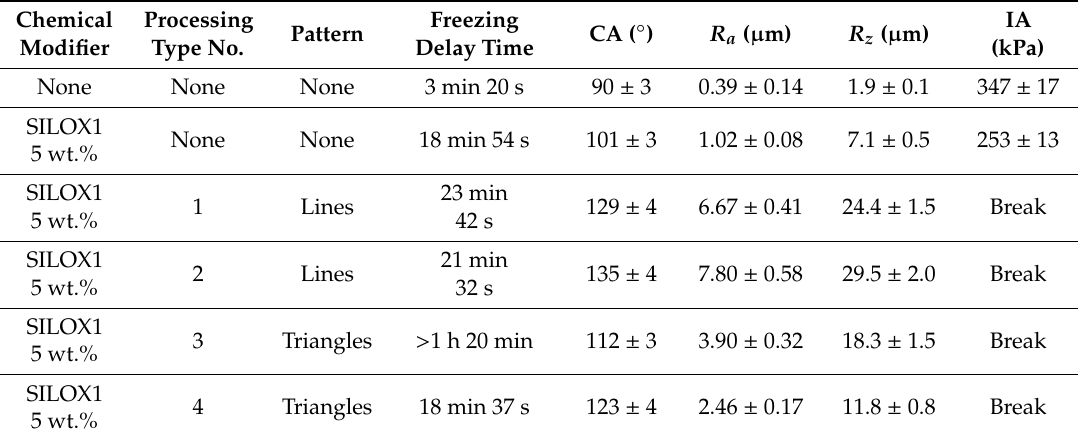
Table 6. Results of freezing delay time test compared with roughness, contact angle and ice adhesion.